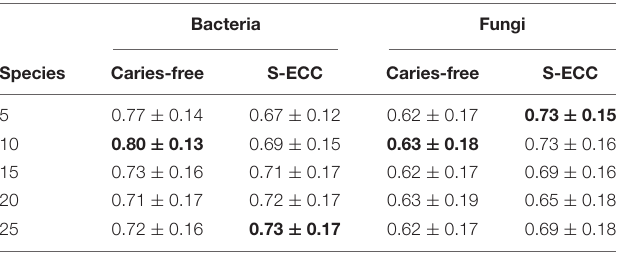
TABLE 3 | Mean AUROC value for plaque vs. swab classification through conditional logistic regression. Bacteria